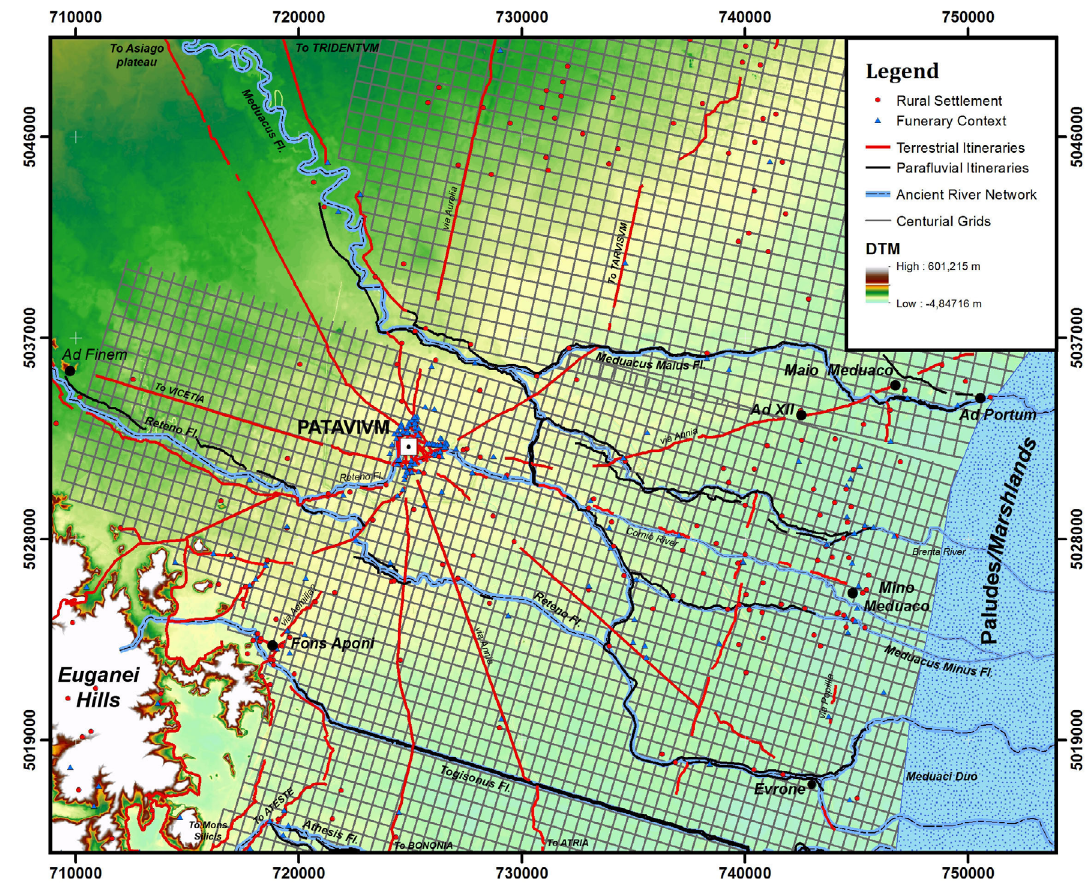
Fig. 10 The road network around Patavium between late 1st century BC and 2nd century